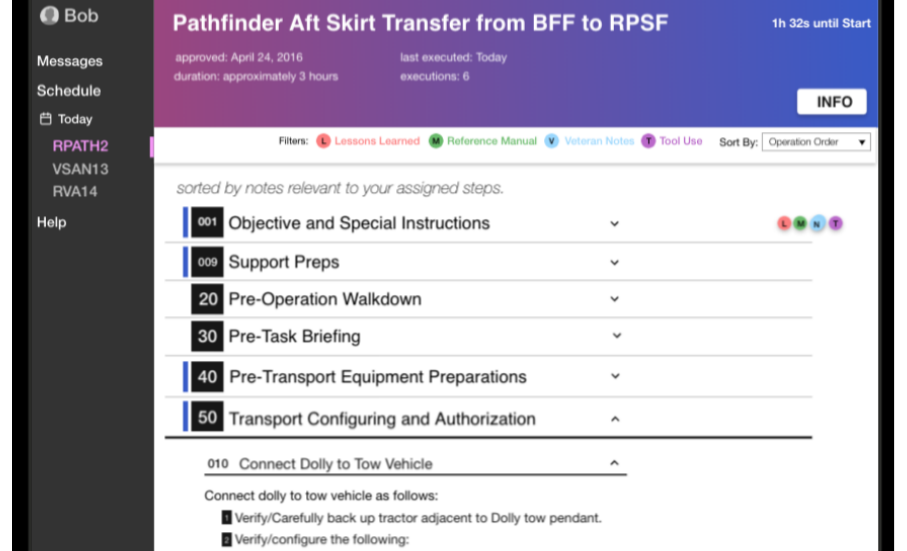
Figure 5. Detail of iPad Procedure